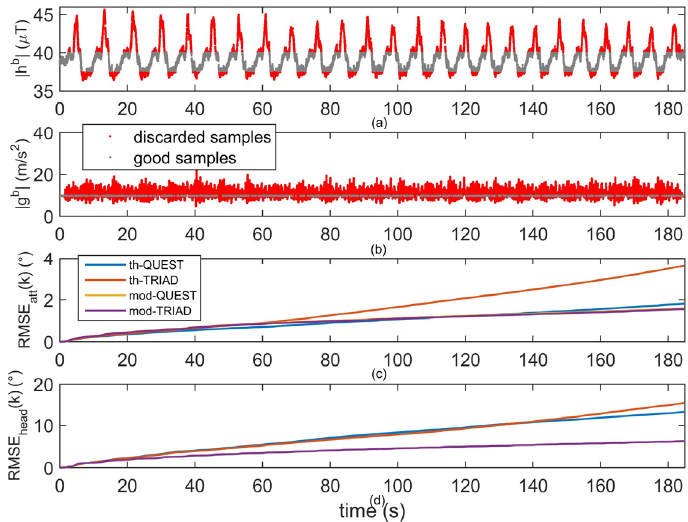
Figure 5. Comparison of the considered methods during the gait task: ( a ) norm of the sensed magnetic field. A magnetic disturbance pattern, related to user’s displacements within the workspace; ( b ) norm of the acceleration measurements; ( c ) RMSE along the heading as a function of time for the four algorithms; ( d ) RMSE along the attitude as a function of time for the four algorithms. In ( a ) and ( b ), the samples accepted by the threshold ‐ based algorithms are reported in gray, while the discarded samples are reported in red.